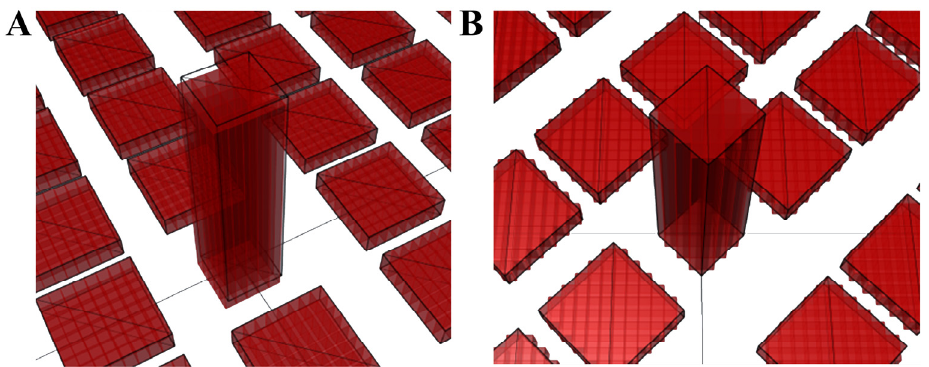
Figure 6. The voxels generated by GH_Wind correspond to the building group when the wind directions are set as ( A ) 0 ◦ and ( B ) 45 ◦ .